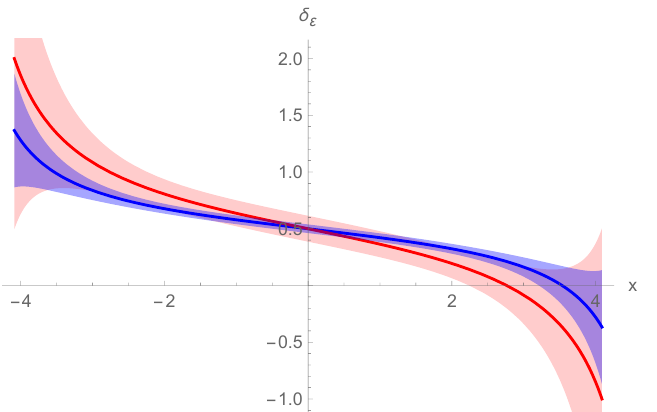
Figure 12: Drifting scaling dimension δ (cid:34) given by the equation (4.33) as a function ) and an estimate of the theoretical uncertainty for Q = 5 (blue) of x = ε log ( r / r 0 and 7